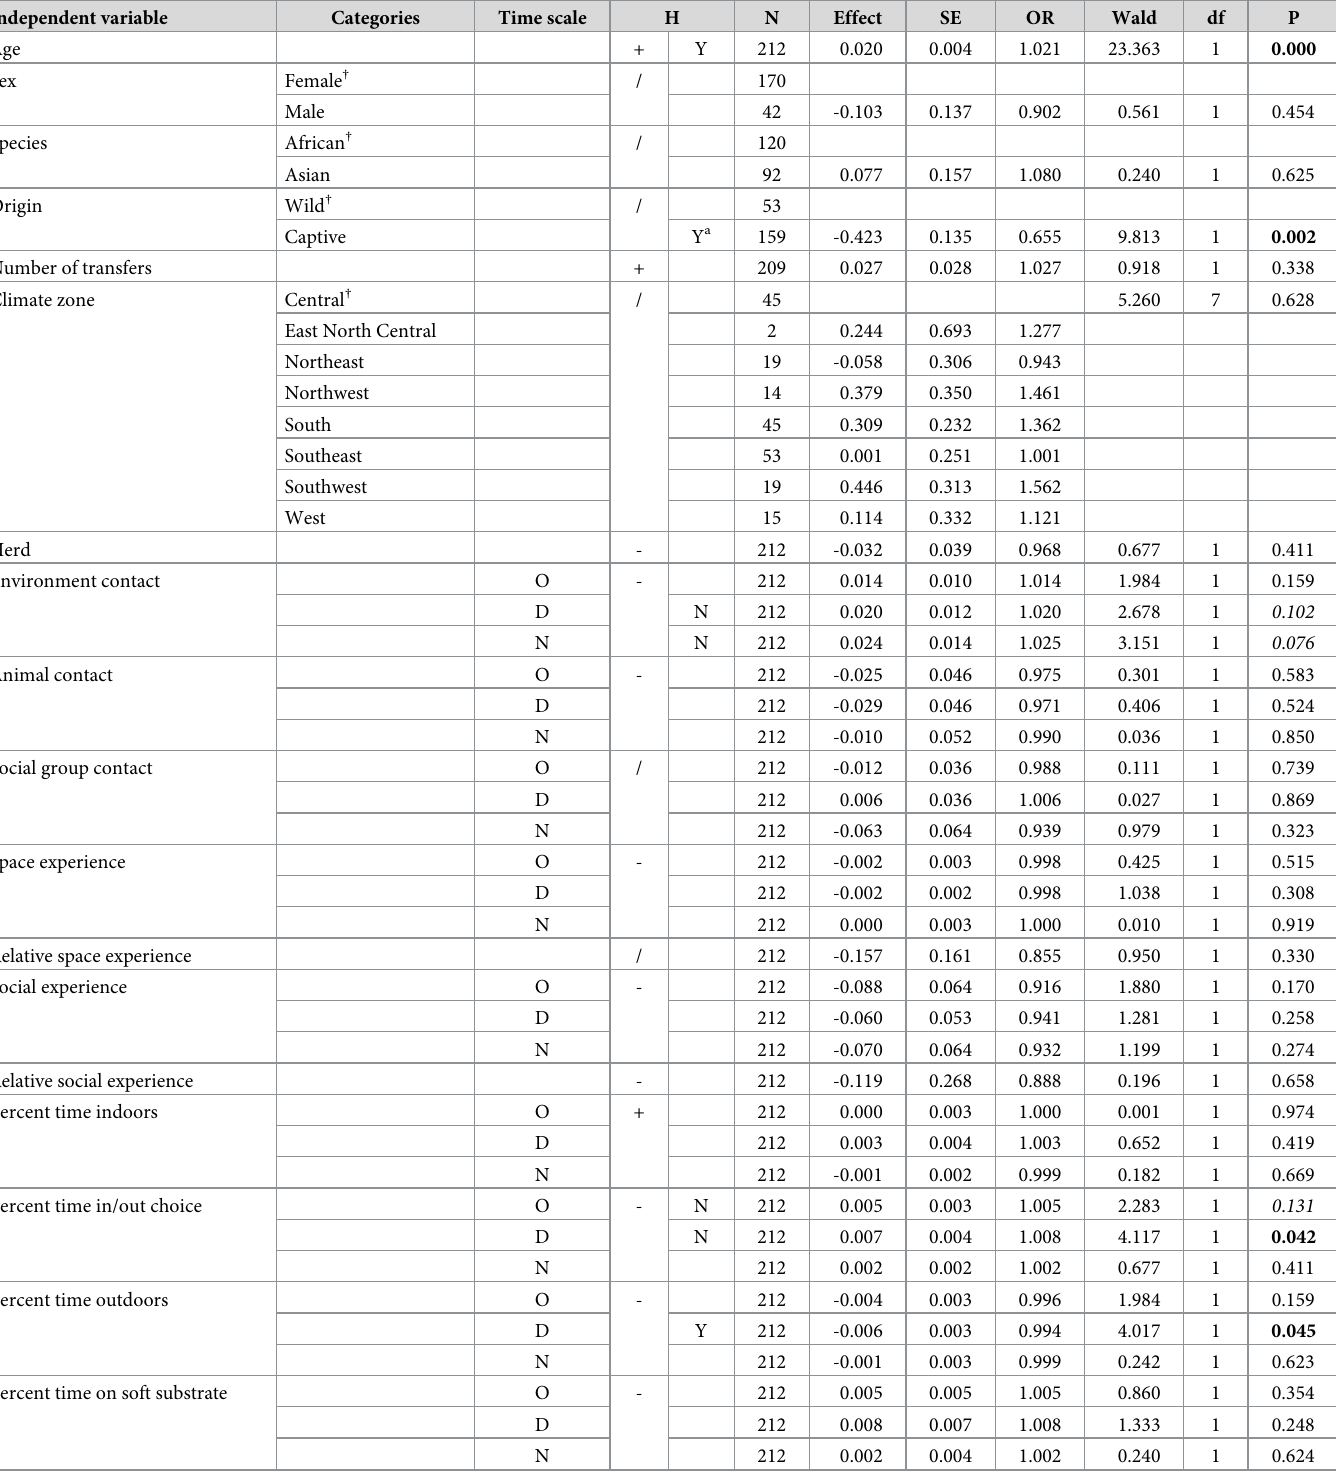
Table 4. Univariate analyses investigating relationships between independent variables and the total number of clinical events per animal in African and Asian ele- phants in North American zoos. Hypotheses (H): positive (+), negative (-), or neutral (/) relationship of each variable with the number of clinical events per animal as a measure of elephant welfare, and whether observed relationships (P < 0.15) were in the predicted direction (Y yes / N